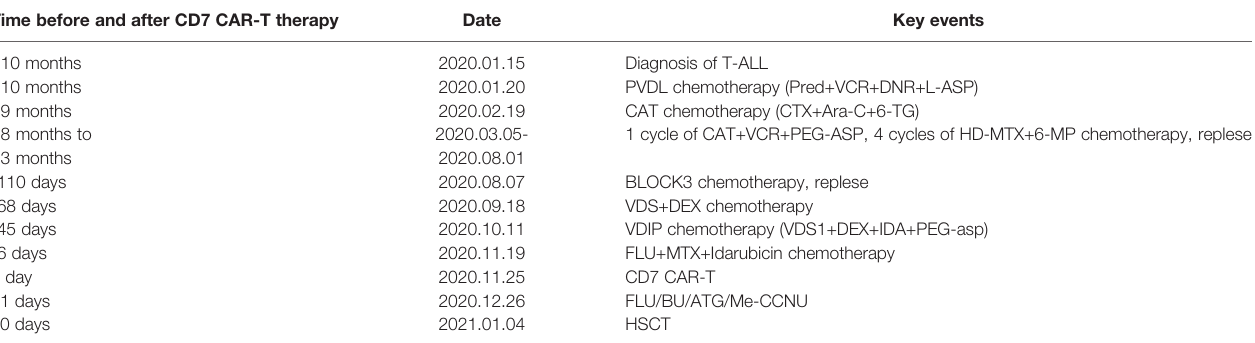
TABLE 1 | Brief chronology of the key clinical events in this case. Time before and after CD7 CAR-T therapy